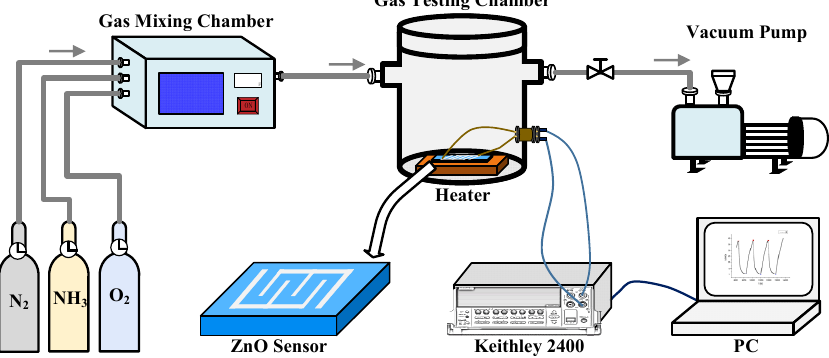
Figure 1. Diagram of the experimental system for NH 3 gas sensing characterization.